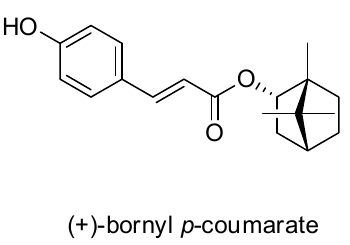
Figure 1. Chemical structure of (+)-bornyl p -coumarate.